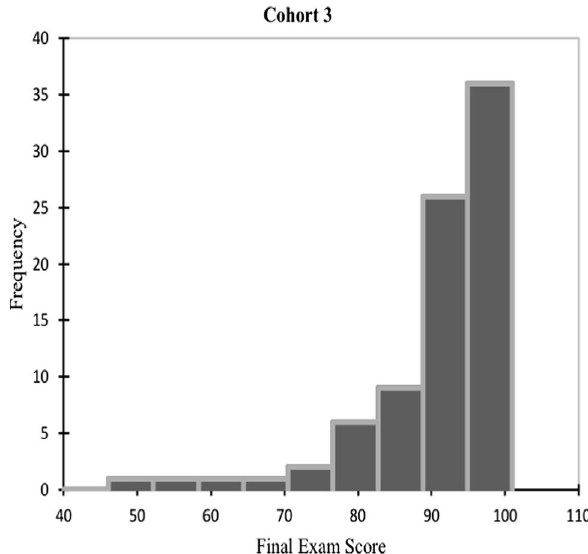
Fig. 3 Histogram of final exam performance in Cohort